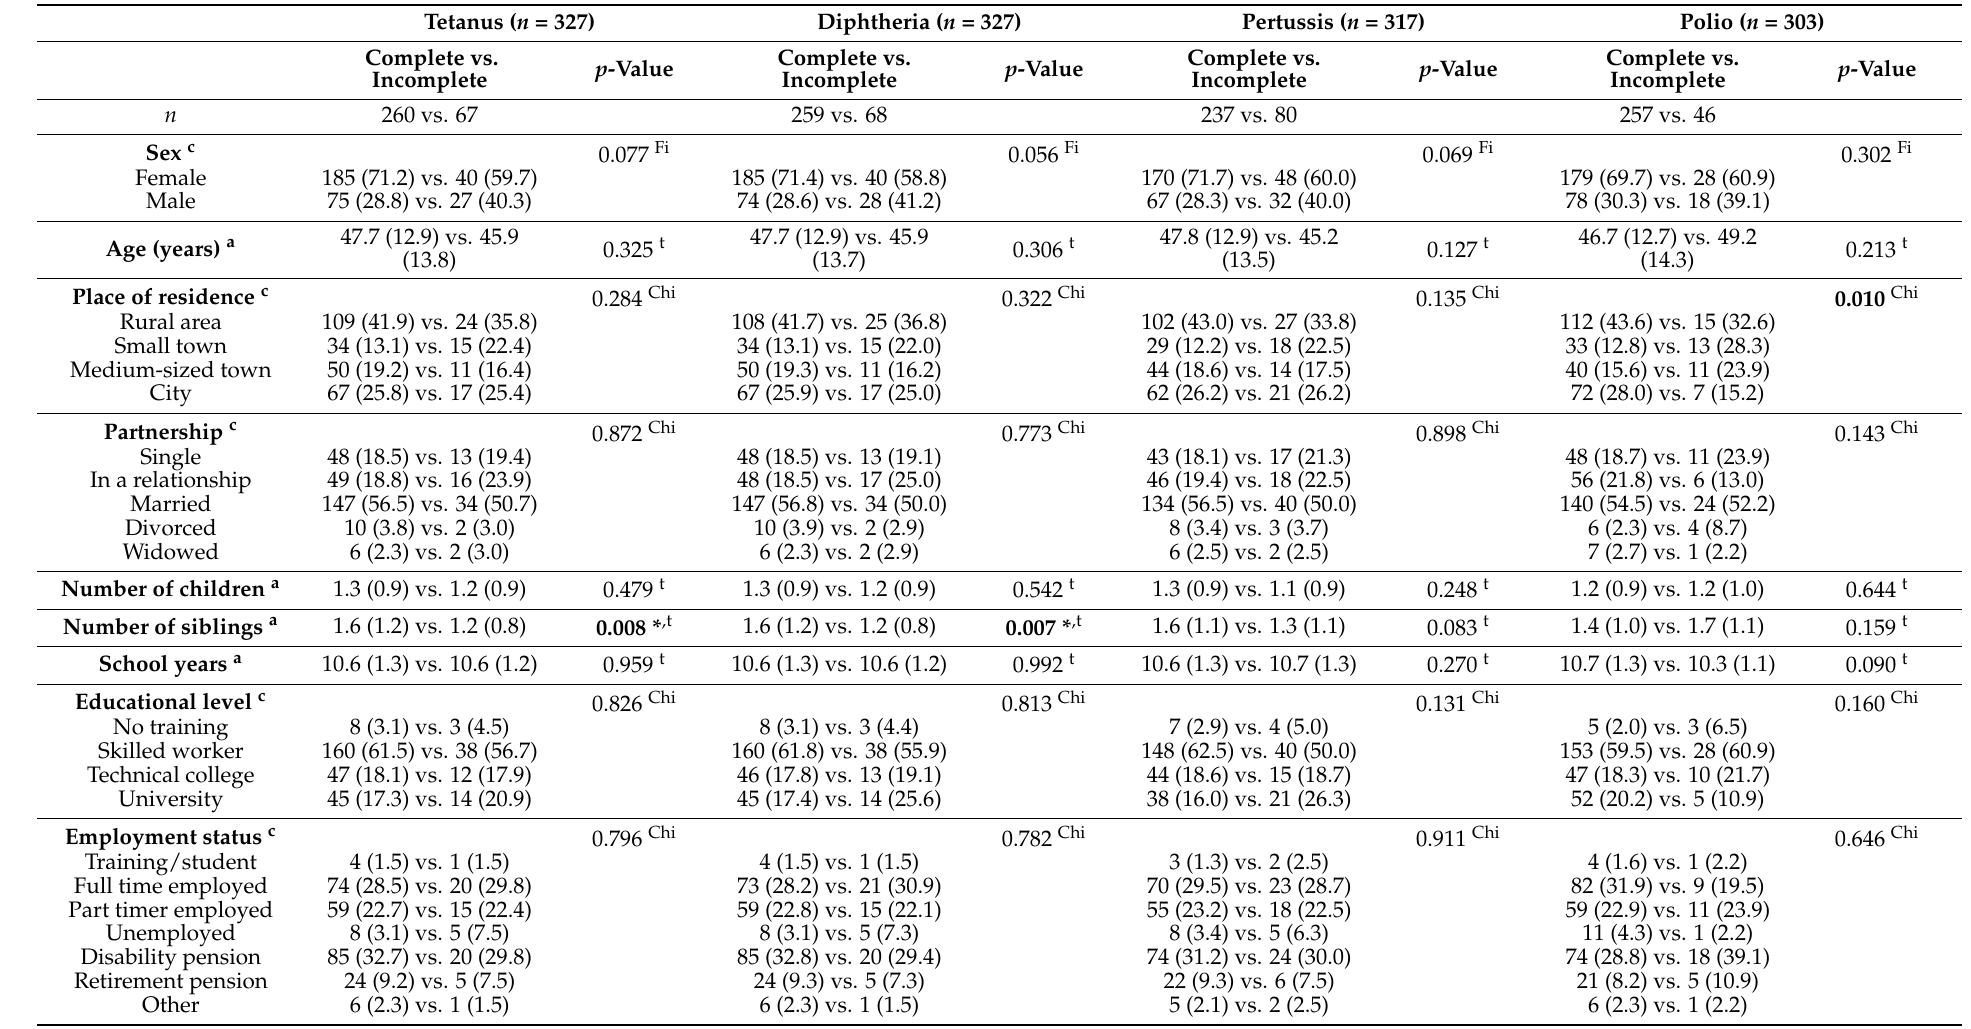
Table 3. Comparison of MS patients with complete vs. incomplete vaccination status with regard to sociodemographic and clinical